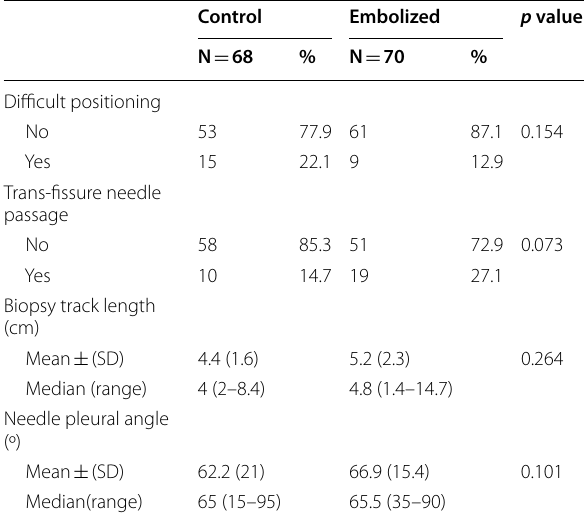
Table 2 Procedure-related risk factors: